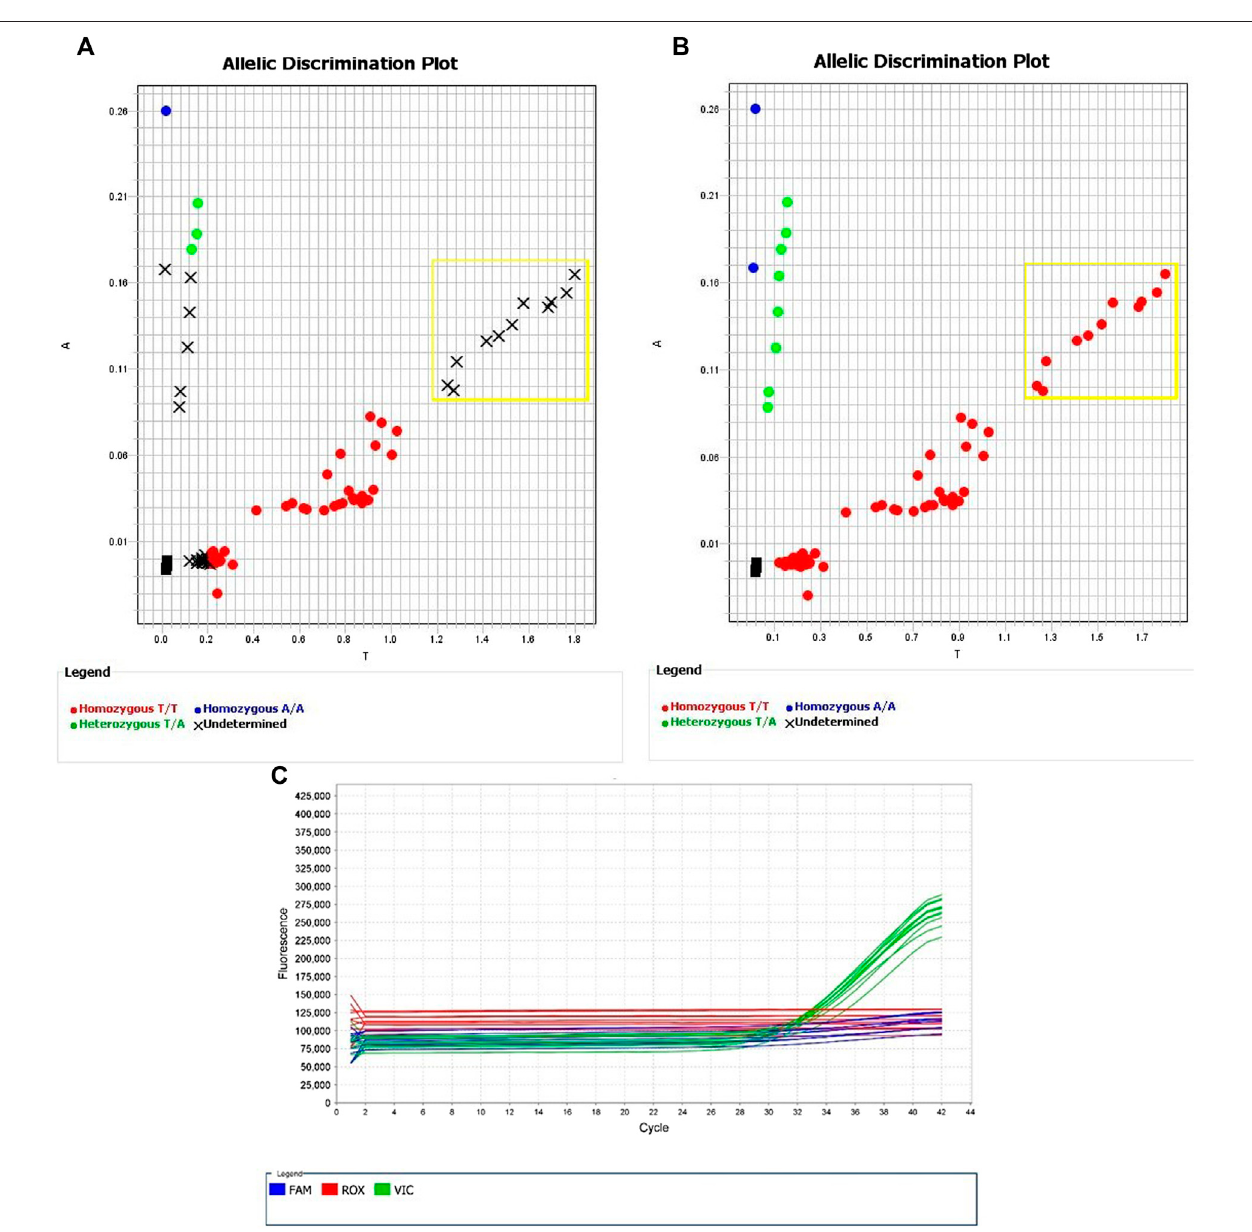
FIGURE 3 | Allelic Discrimination Plots and Multicomponent Plot for AN2XMRN (rs144012689, rs2596496C)Samples in the yellow box showed most signi fi cant ampli fi cation (NA17235, NA17256, NA18545, 689, 691, 755), in comparison to the rest of the samples. This group likely has the nucleotide base C at rs2596496. (A) shows the software-generated calls, and (B) shows manually assigned calls based on relative fl uorescence. (C) Fluorescence of VIC dye on multicomponent plot for NA17235, NA17256, NA18545, 689, 691, 755 (samples in yellow box) indicates homozygous T/T call.